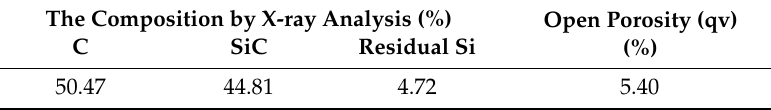
Figure 3. The finite element analysis model.